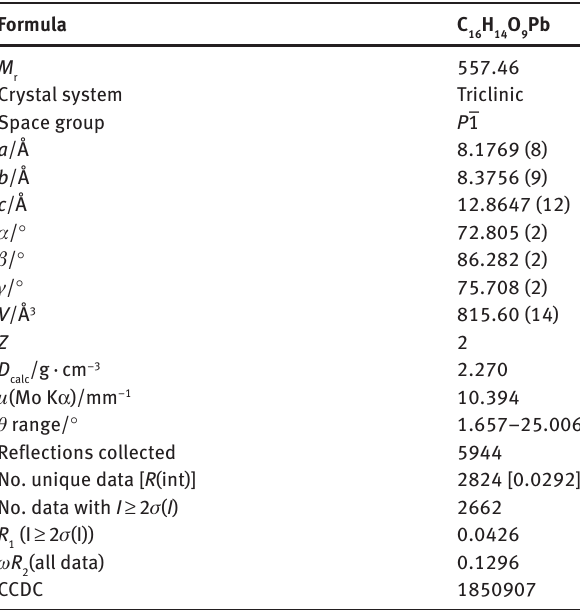
Table 1: Crystallographic data and refinement parameters for complex 1